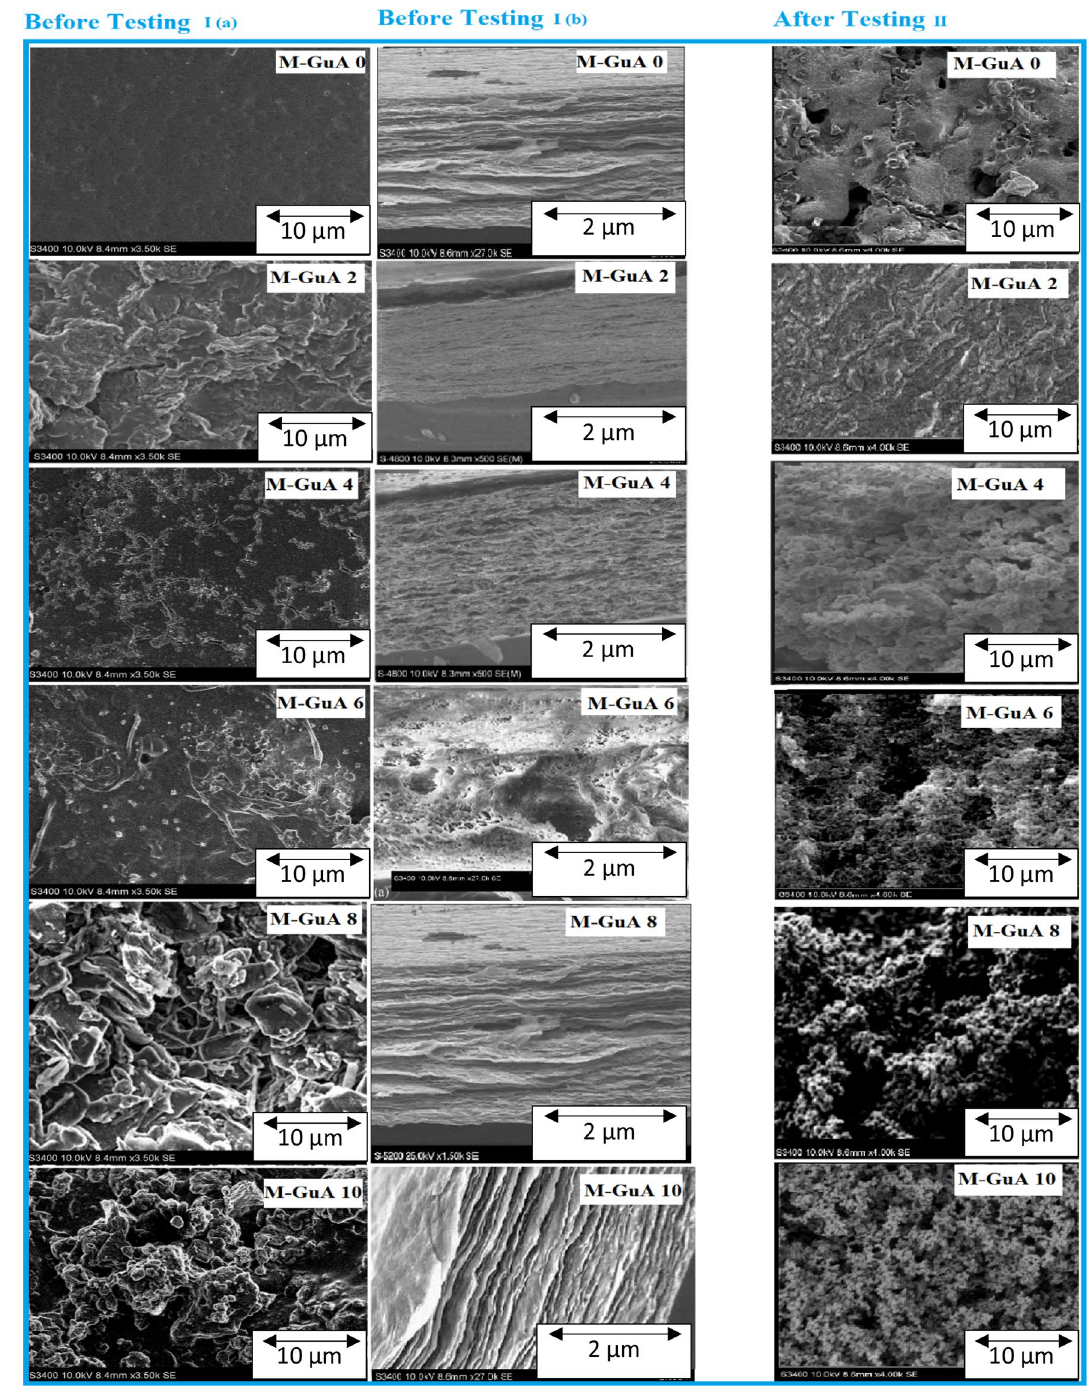
Figure 3. (I) Surface magnification ( a ) top surface ( b ) cross section of membranes at different magnifications (II) post SEM images of M-GuA